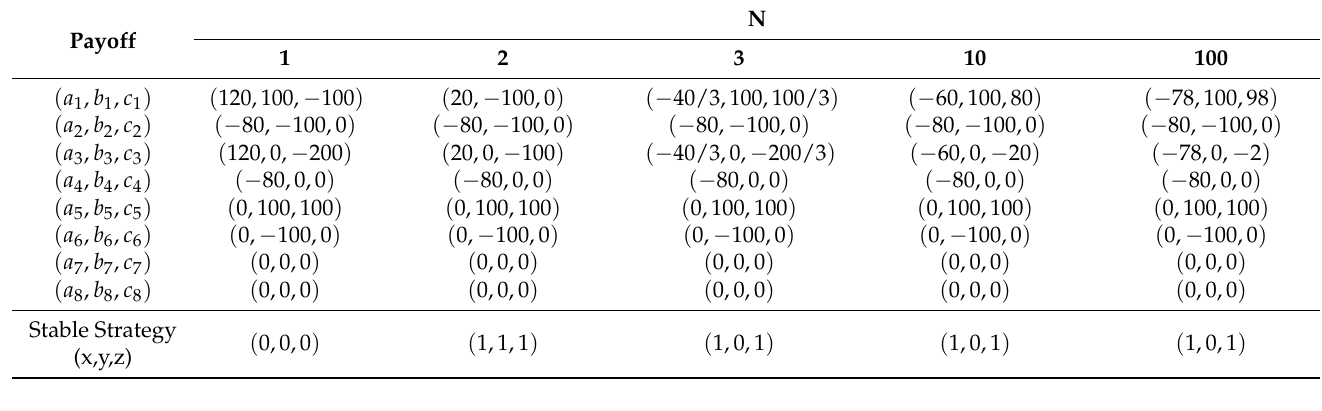
Table 8. Experiment results when provides real services.